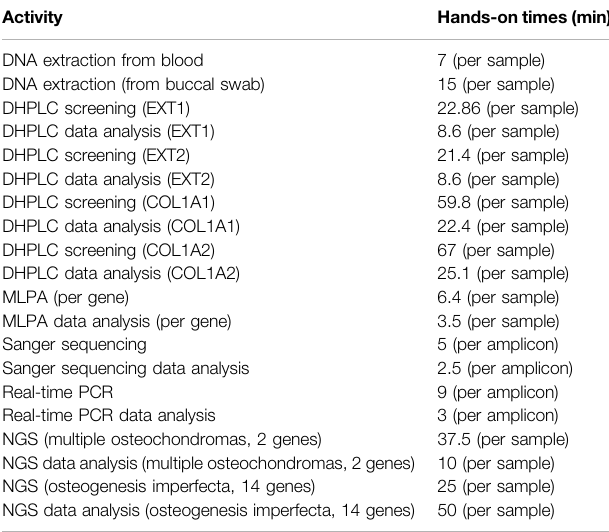
samples, CNV detection was performed using a speci fi c algorithm based coverage